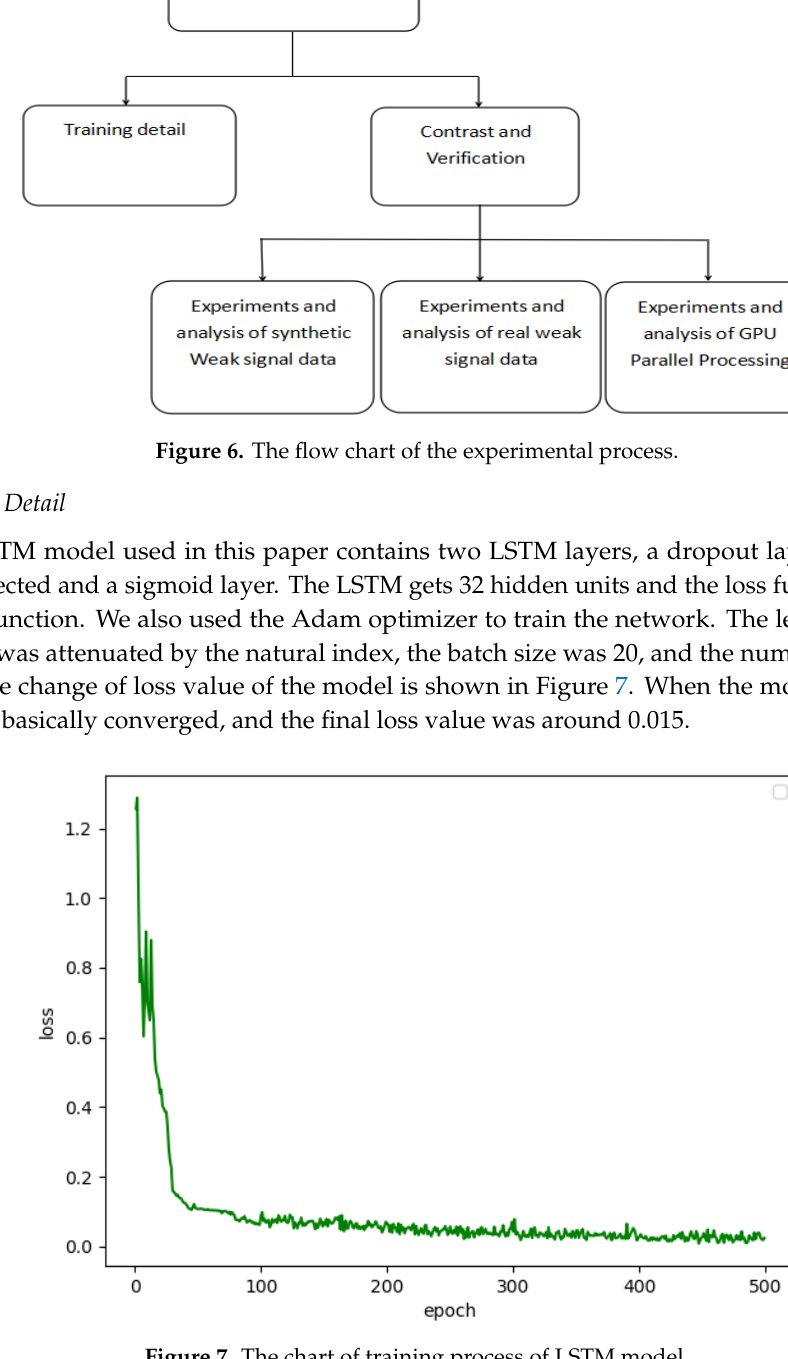
Figure 7. The chart of training process of LSTM model.